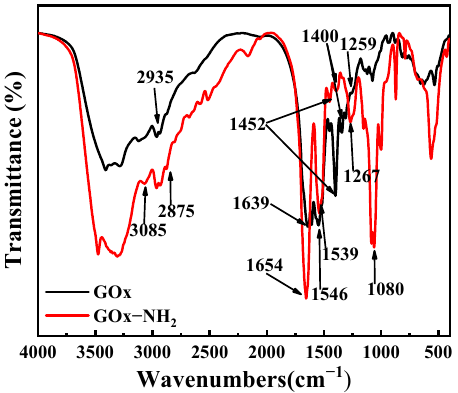
Figure 3. Fourier-transform infrared (FTIR) spectra of unmodified GOx and GOx-NH 2